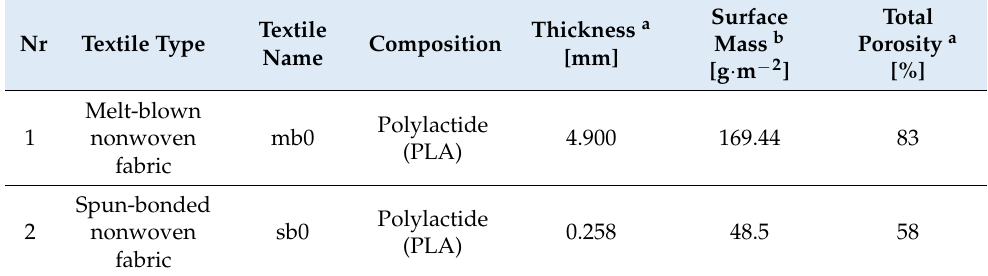
Table 1. Characteristics of tested nonwovens.